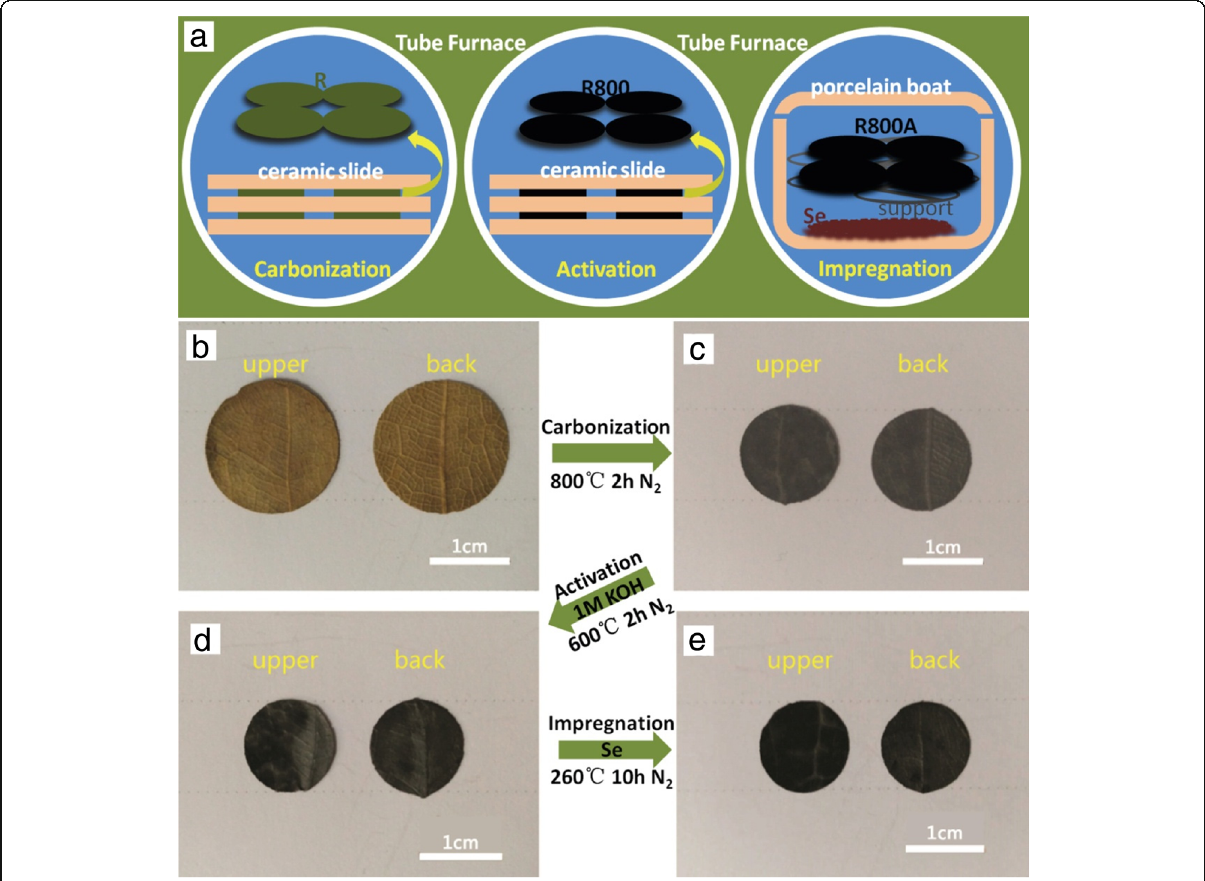
Fig. 1 a Schematic illustration showing the preparation processes of the Se-R800A free-standing electrode. Digital photographs of b the dried R, c the R800, d the R800A, and e the